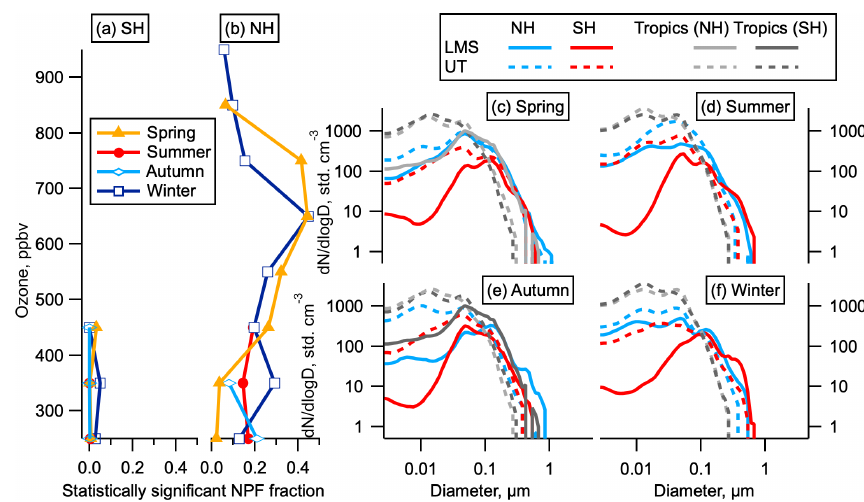
Figure 3. Statistically significant NPF and size distributions by hemisphere. (a, b) The fraction of data indicating statistically significant NPF as a function of ozone for each hemisphere and season. Data are limited to altitudes above 8km. (c–f) Average size distributions in the LMS and UT in the NH (latitudes above 30 ◦ ), SH (latitudes below − 30 ◦ ), and tropics ( − 30 to 30 ◦ ) by season. The LMS was not sampled in the tropics except in May. Tropics are shown both for the month corresponding to the NH season (dark grey) and the SH season (light grey); e.g. in spring the tropical May observations are shown in light grey and the tropical October observations are shown in dark